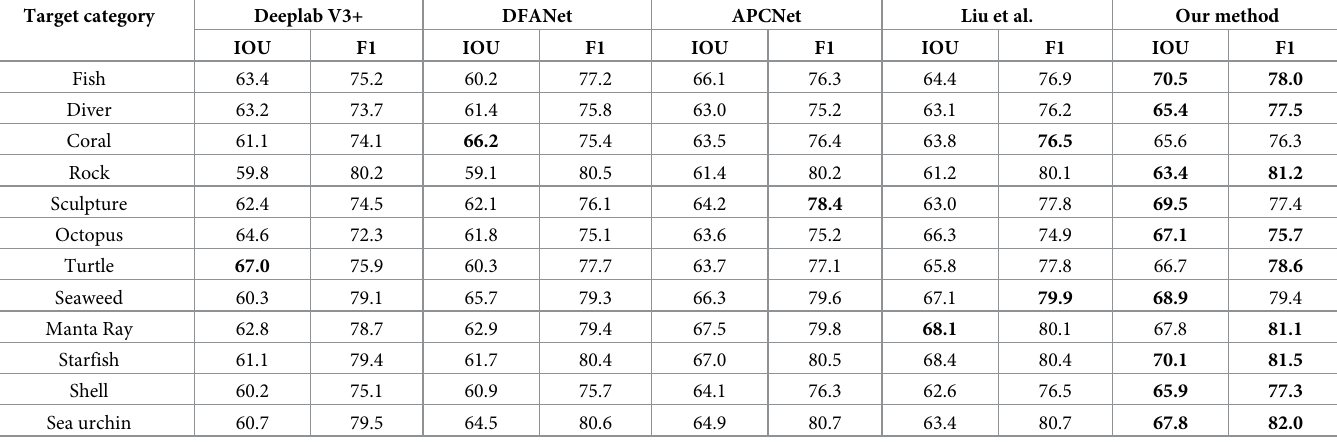
Table 3. Comparison of IOU and F 1 values between our method and the other four state-of-the-art methods on the underwater dataset. The best results are marked in bold. Target category